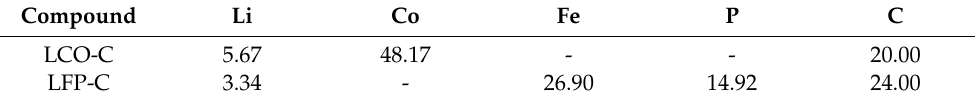
Table 1. Composition of the mixture of cathode material and graphite powder in wt.%.